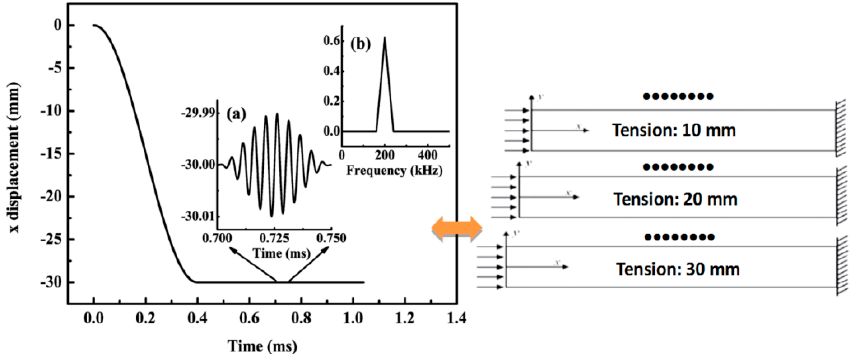
Figure 4. Actuating function of excitation signal with stretching length l = 30 mm and T = 0.8 ms: ( a ) time domain and ( b ) frequency domain.